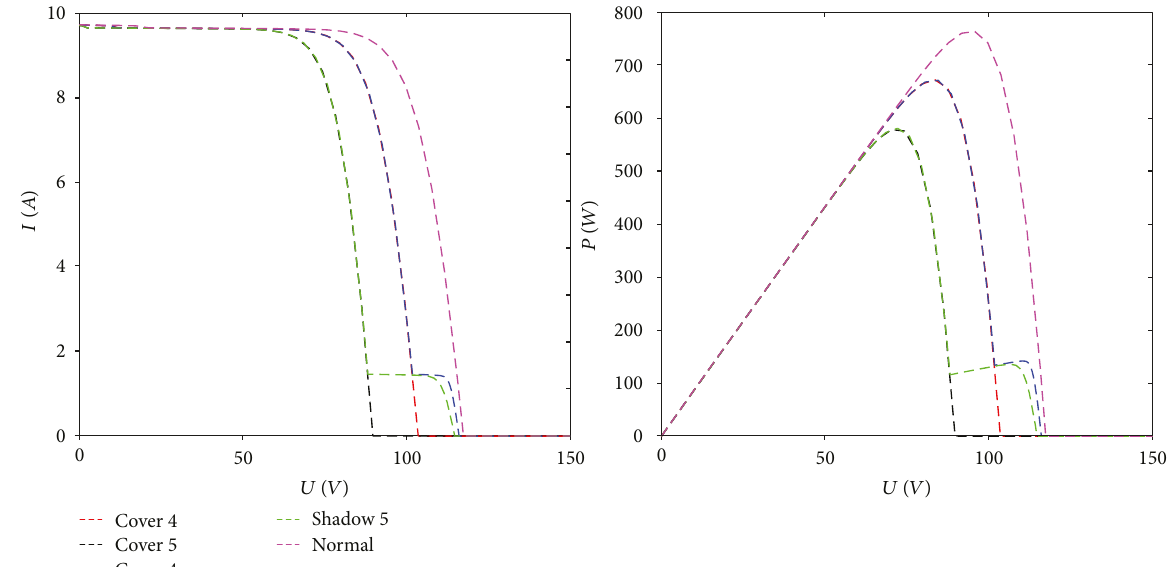
Figure 10: Comparison between shadow and cover conditions. The di ff erence between shadow and cover is whether the open-circuit voltage drops or not.